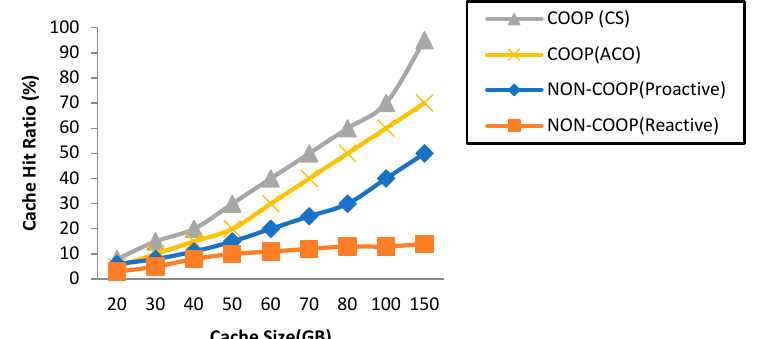
Figure 6. Cache hit ratio with different cache Figure 6 . Cache hit ratio with different cache sizes .